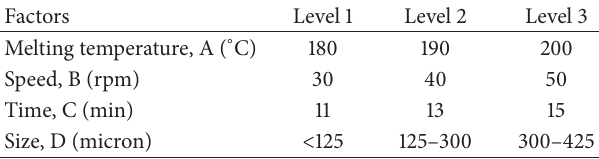
Table 2: The parameters for three levels of selected factors.